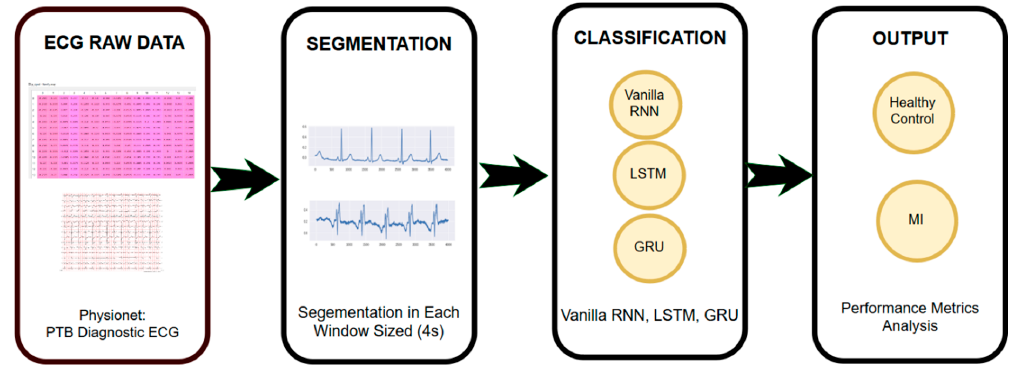
Figure 1. Electrocardiogram (ECG) processing.